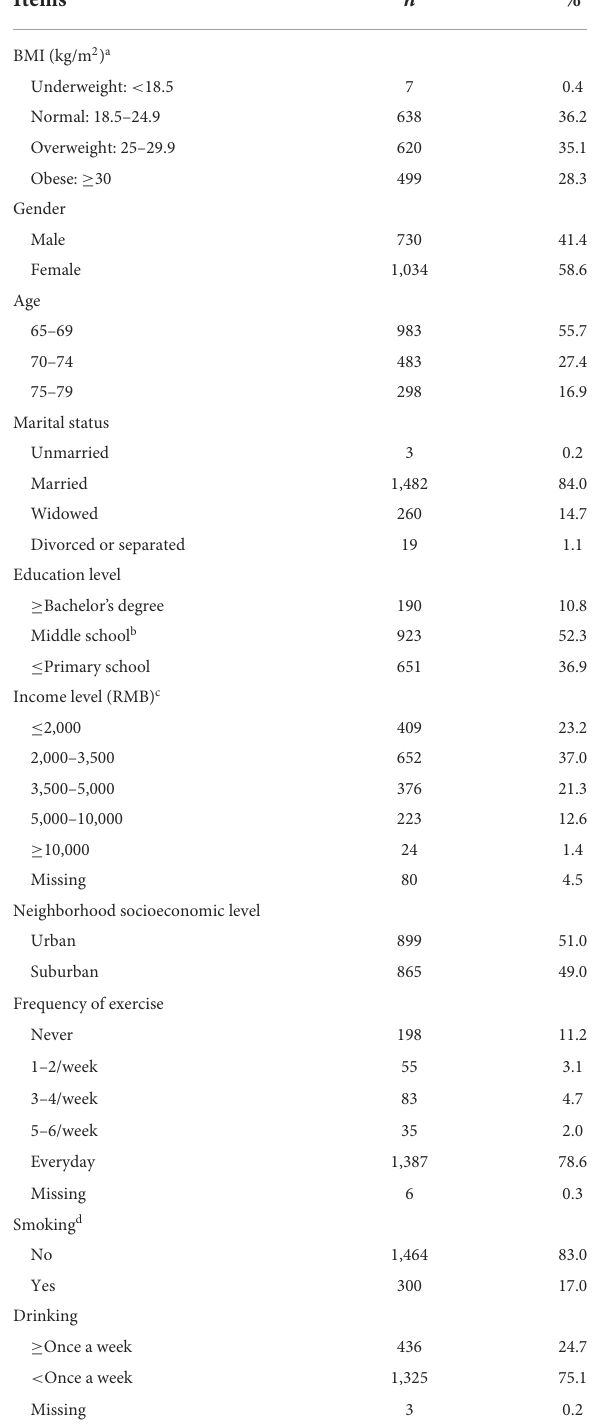
TABLE 2 Characteristics of the participants ( n ,